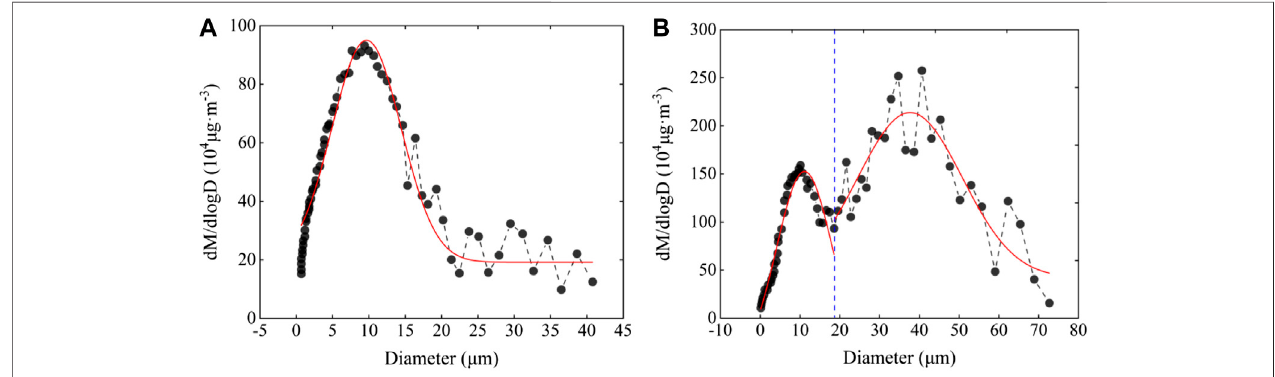
FIGURE 6 | Mass – size distributions of dust in snow at Yushugou Glacier No. 6 during the (A) non-dust and (B) dust periods.